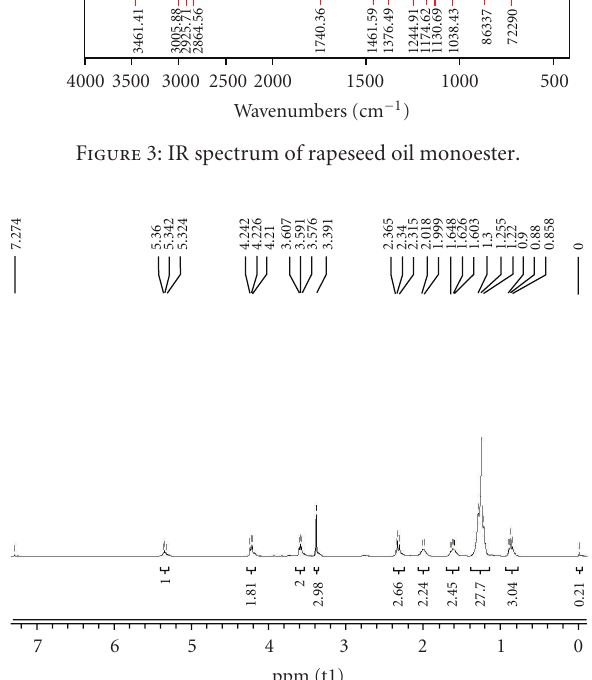
Figure 4: P 1P H NMR spectrum of rapeseed oil monoester.